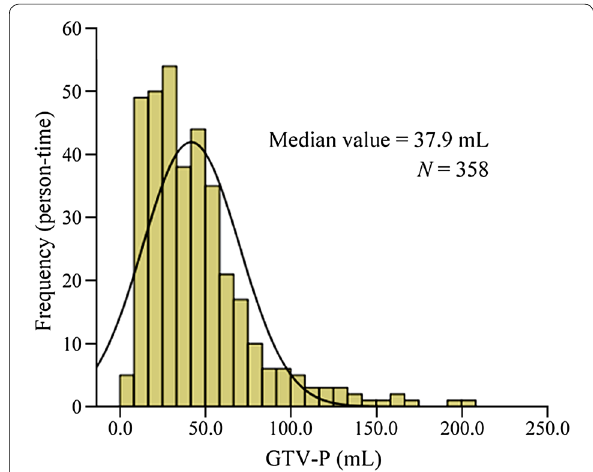
Fig. 1 Histogram of the gross target volume of primary tumor (GTV‑ P) in patients with locally advanced nasopharyngeal carcinoma (NPC)